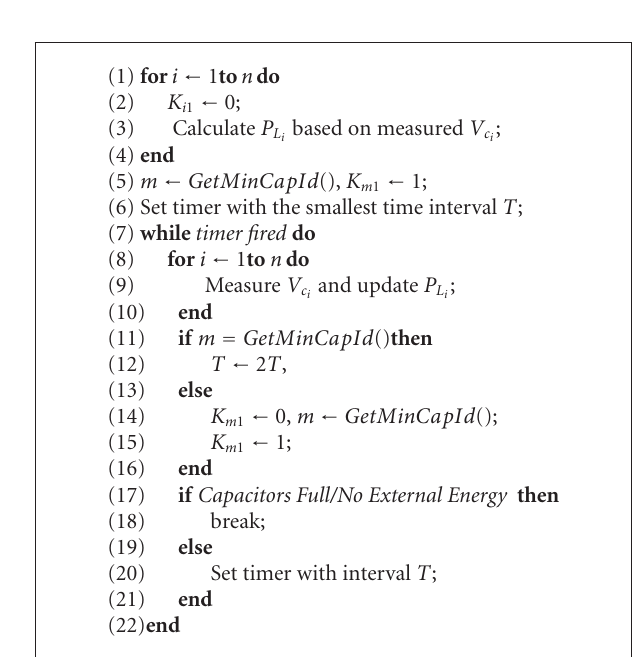
Figure 6: Charging control example.